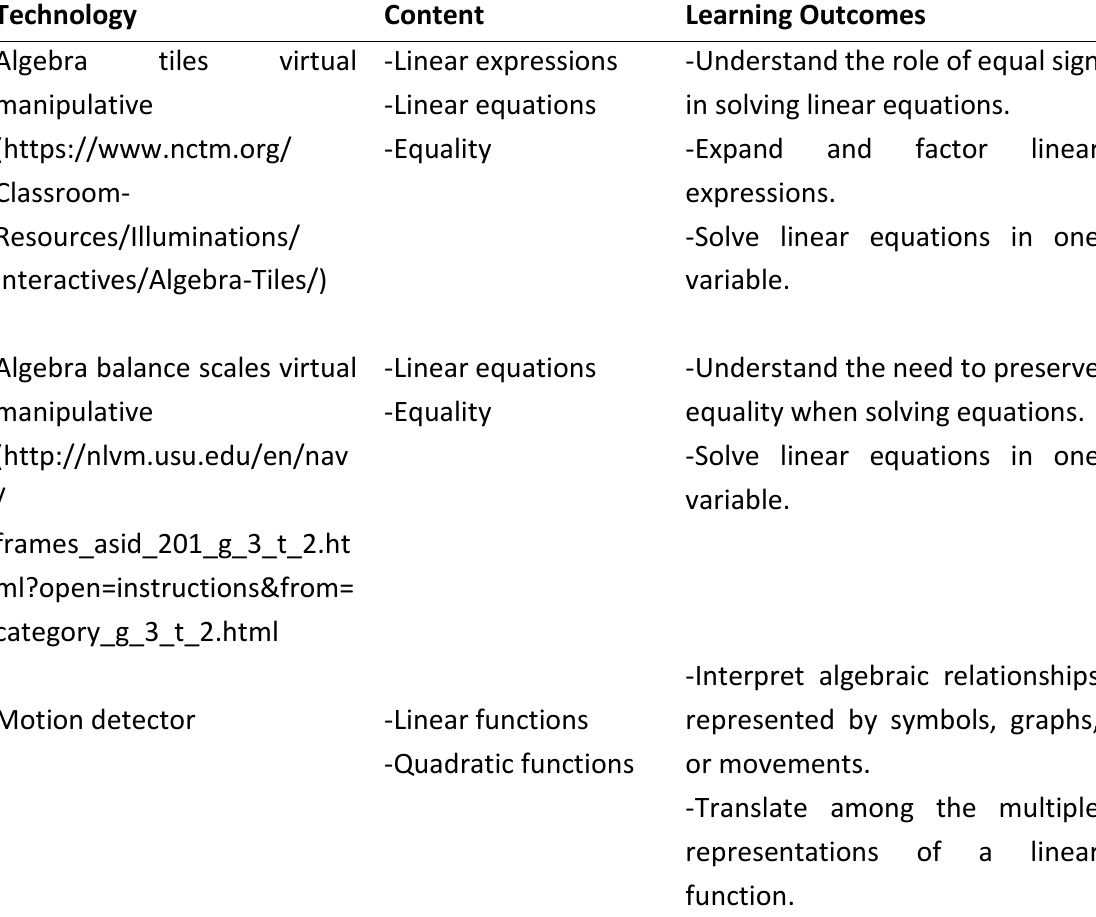
Table 1. Example Technologies Used in the Professional Development